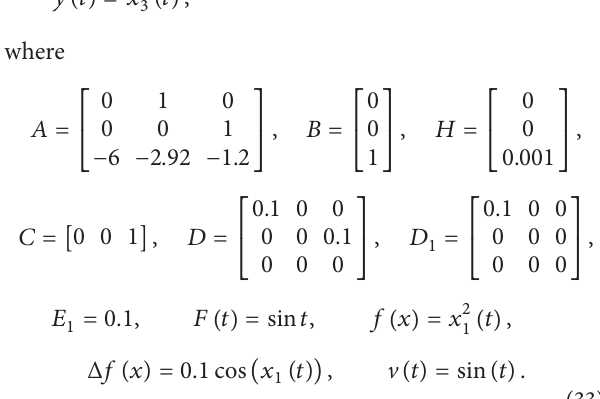
Figure 2: The control input 𝑢(𝑡)